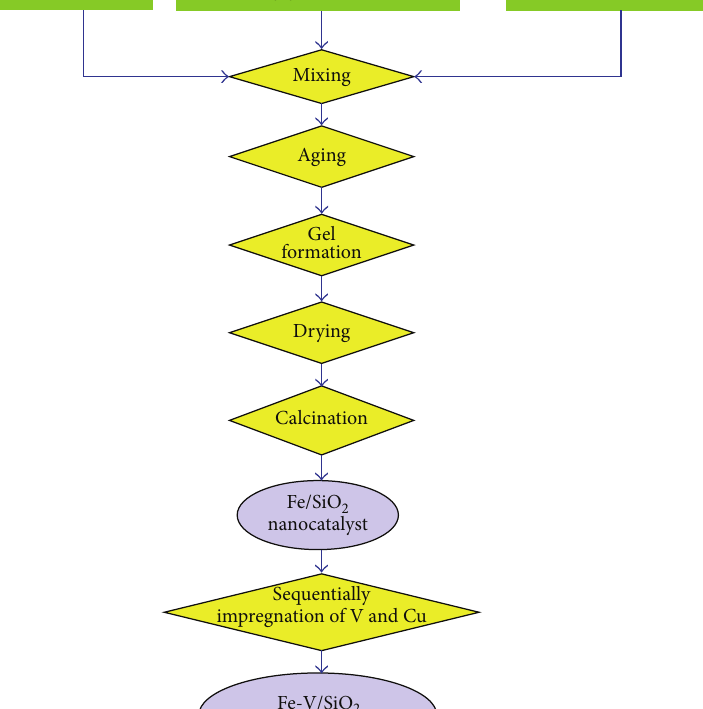
All spectra were taken in the range 4000–400 cm −1 at